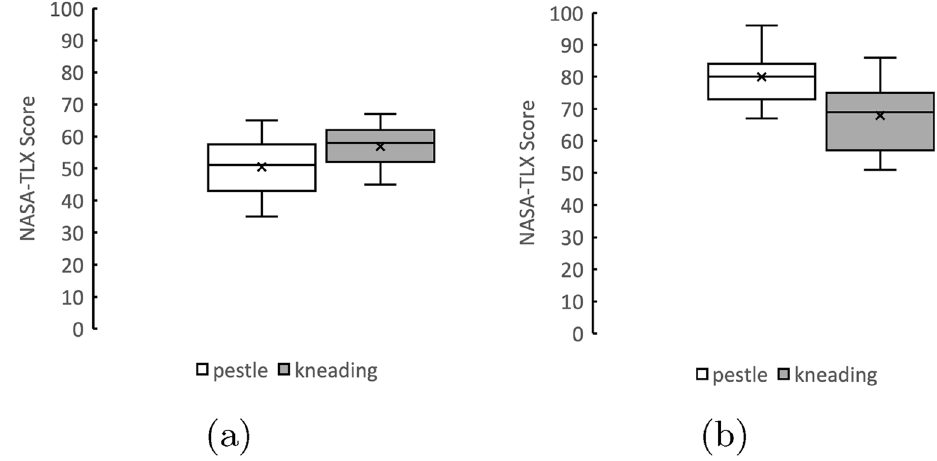
Fig. 5 Reported NASA-TLX Scores for a implicit pairs and b explicit pairs